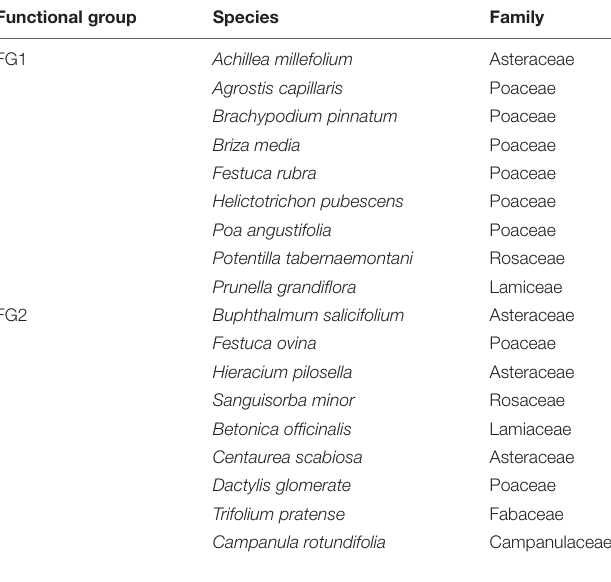
TABLE 1 | Species composition, families, and functional groups included in the two selected experimental communities. Functional